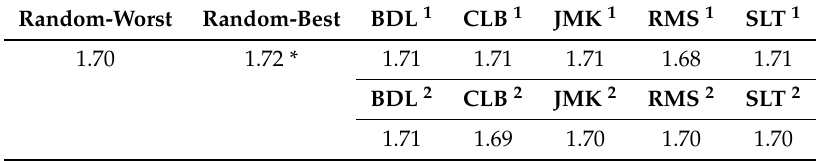
Table 6. Mean PESQ results for RMS voice. Higher values represent better results.